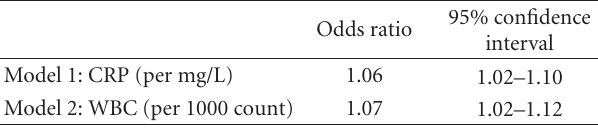
Table 4: Results from logistic regression model that evaluated the role of CRP and WBC (independent covariates) on the occurrence of LVSD in patients who had had an acute coronary event, after adjustment for several common confounders ∗